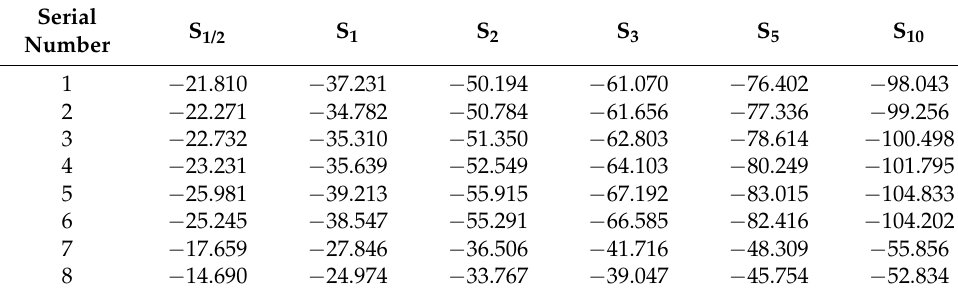
Table 3. Structural response data